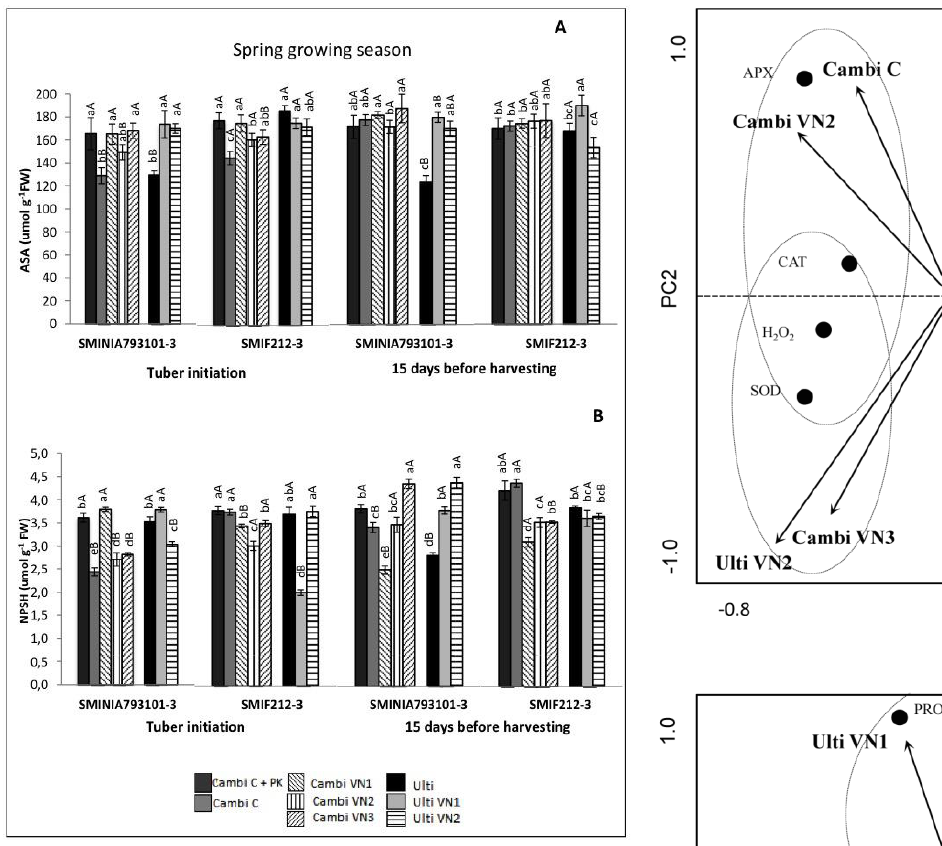
Fig. 7: Effect of increasing Cu levels on AsA (A) and NPSH (B) leave concentrations in different development stages (tuber initiation and 15/18 days before harvesting) of different potato genotypes at spring growing season. Data represent the mean ± S.D. of six replicates. Different lowercase letters indicate significant differences between Cu levels in the same potato genotype (p < 0.05). Different capital letters indicate significant differences between potato genotypes at the same Cu level (p < 0.05).